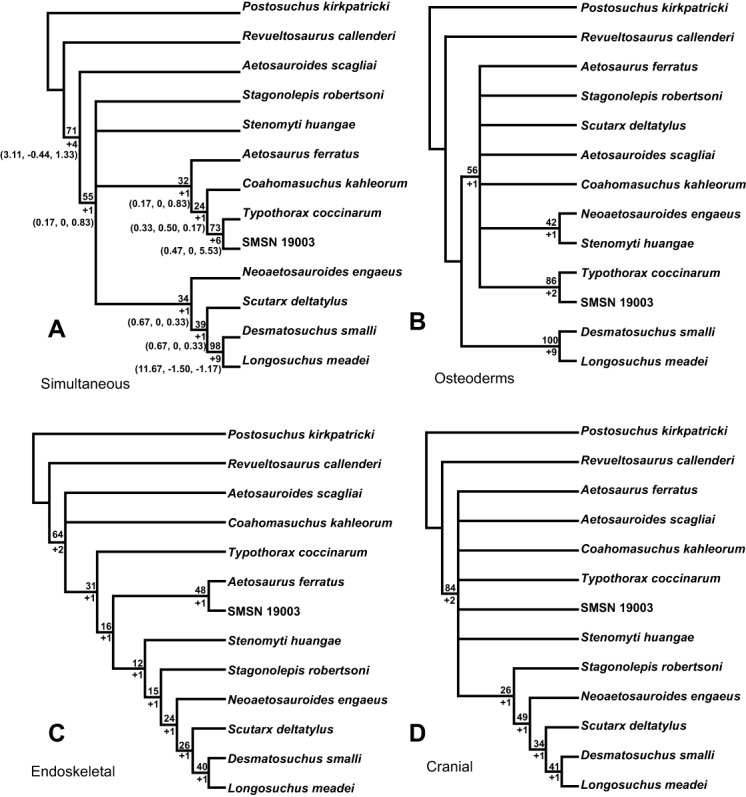
Phylogenetic trees recovered from partitioning the main dataset.Decay indices and bootstrap values (1000 replicates) listed for all nodes. (A) Topology of a three MPTs from the simultaneous (13 taxa, 83 characters) dataset. Partitioned Bremer Support values for nodes are given in parentheses. The first value pertains to the cranial only characters, the second from the postcranial characters, and the third from the osteoderm characters; (B) Topology of a three MPTs recovered for the osteoderm dataset; (C) Strict consensus tree from two MPTs from the complete non-osteoderm (endoskeletal) dataset (cranial, axial, appendicular); (D) Strict consensus of 13 MPTs from analysis of the cranial dataset.